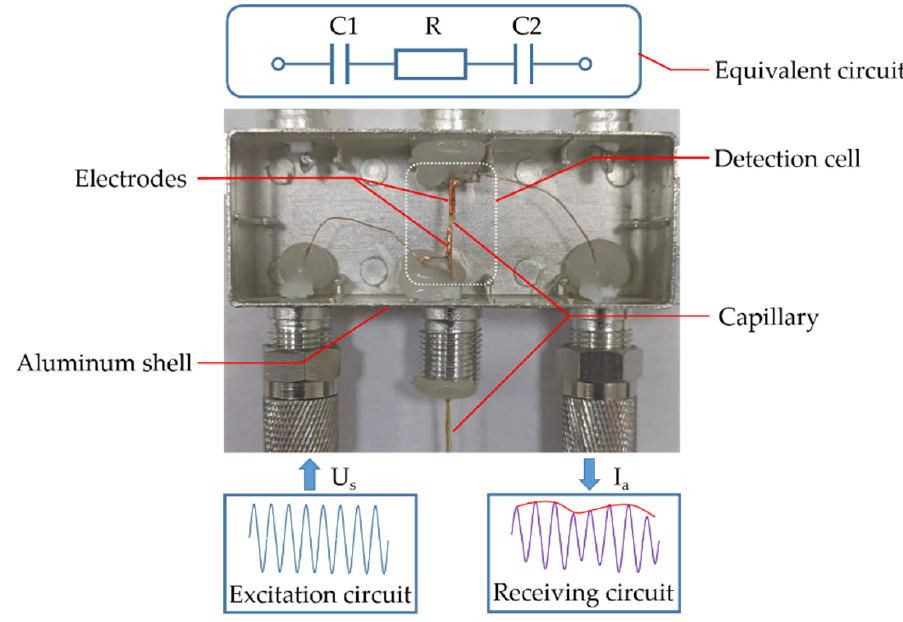
Figure 1. Schematic diagram of C4D detector.